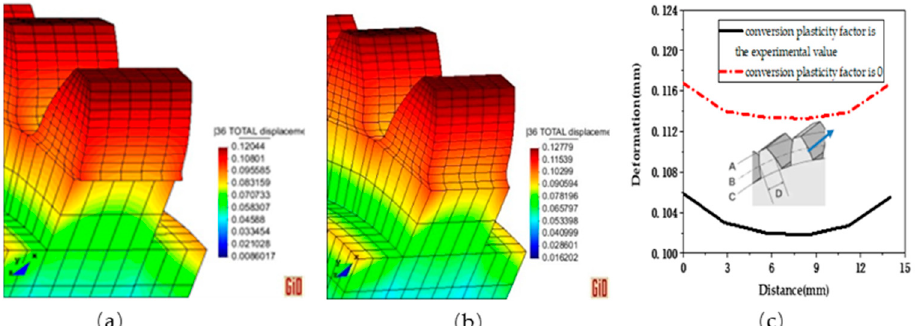
Figure 11. Distortion results of 20CrMnTiH steel gears after carburizing and quenching. ( a ) The 3D distortion results with considered transformation plasticity; ( b ) the 3D distortion results without transformation plasticity; ( c ) distortion results at the gear knuckle after carburizing and quenching.